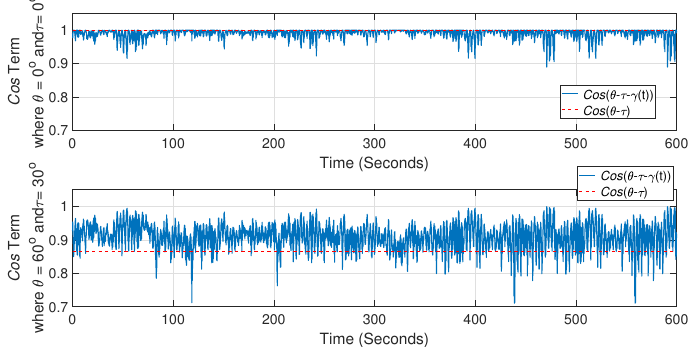
Figure 14. Cos term evaluation for above-rated wind speed (22 m/s) for set with θ = 0 ◦ , τ = 0 ◦ ( above ) and for set with θ = 60 ◦ , τ = 30 ◦ ( below